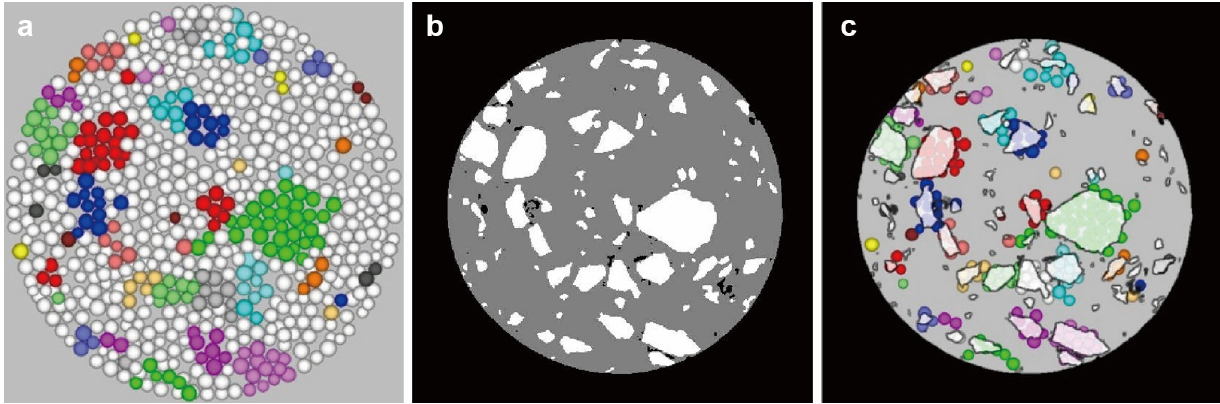
Fig. 9 Comparison between the selected cross section of the PFC3D model and the prototype CT image, a the cross section truncated from the constructed PFC3D model, b the prototype CT image of the selected cross section, c comparing the rock gravels that are represented in PFC3D model with the real ones that are shown in the CT